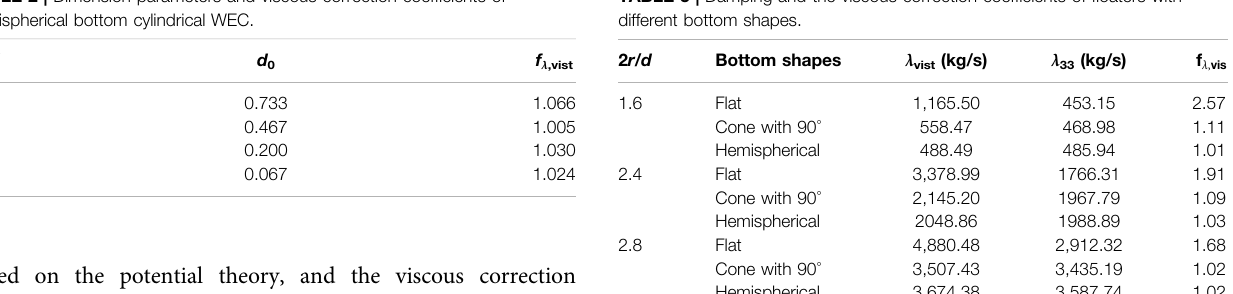
three different DDRs of 2 r / d (cid:2) 1.6, 2.4, and 2.8 are taken as